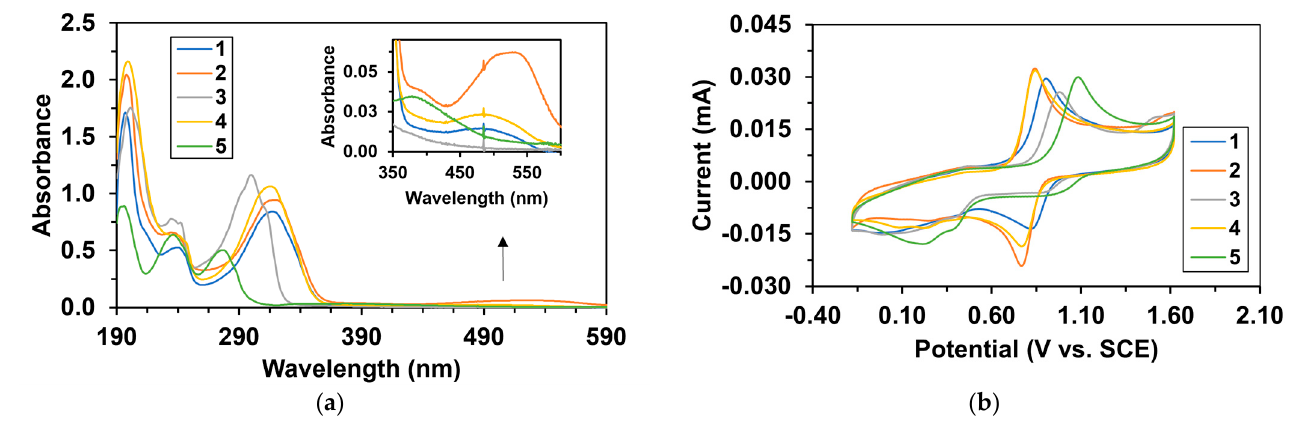
Figure 1. Characterization of [Fe II (L 1 -L 5 )] 3 ](CF 3 SO 3 ) 2 ( 1 – 5 ) (L 1 = 2-(2 ′ -pyridyl)- 1 H -benzimidazole; L 2 = 2-(2 ′ -pyridyl)- N -methyl-benzimidazole; L 3 = 2-(4-thiazolyl)-1 H -benzimidazole; L 4 = 2-(4 ′ -methyl- 2 ′ -pyridyl)-1 H -benzimidazole; L 5 = 2-(1 H -1,2,4-triazol-3-yl)-pyridine) complexes. ( a ) Electronic spectra of [Fe II (L 1 -L 5 )] 3 ](CF 3 SO 3 ) 2 ( 1 – 5 ) complexes: [ 1 – 5 ] = 2.0 × 10 − 5 M, T = 293 K, l = 1 cm, V = 2 mL MeCN. ( b ) Cyclic voltammograms of [Fe II (L 1 -L 5 )] 3 ](CF 3 SO 3 ) 2 ( 1 – 5 ) complexes: [ 1 – 5 ] = 1.0 × 10 − 3 M, in (0.1 M TBAClO 4 ) MeCN (10 cm 3 ), scan rate: 500 mV/s.